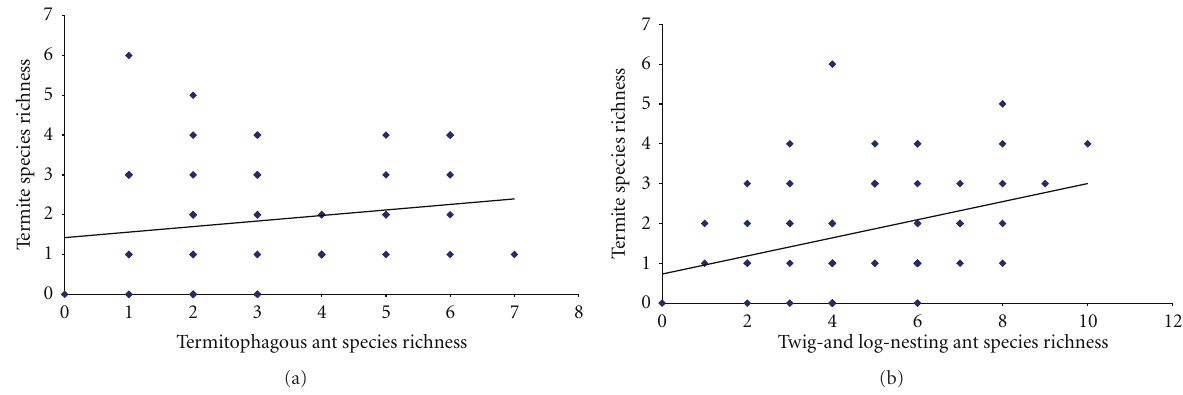
Figure 3: Correlation between termite species richness and (a) the species richness of ant genera known to contain termite predators (Spearman’s Rho = 0.239, P = 0 . 068, n = 60) and (b) the species richness of twig and log nesting ant species (Spearman’s Rho = 0.482, P = 0 . 007, n = 60).